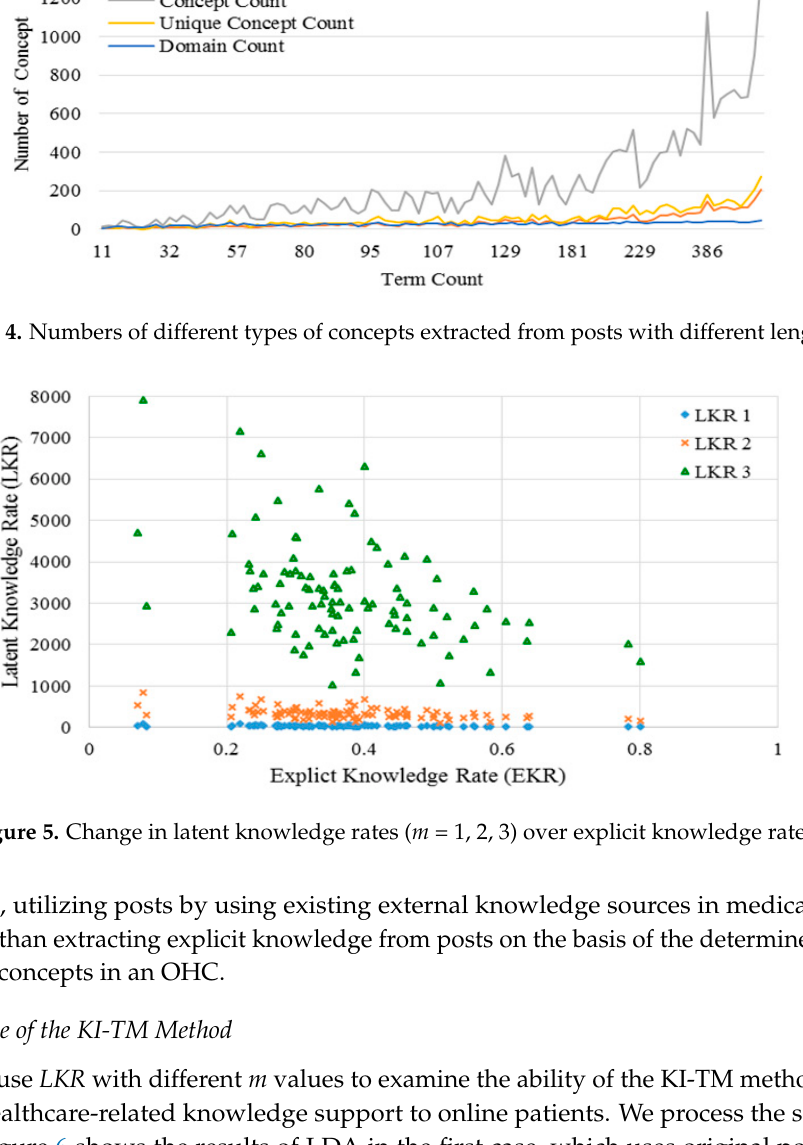
Figure 6. Comparison of frequency values of five topics with top five terms by using original posts.